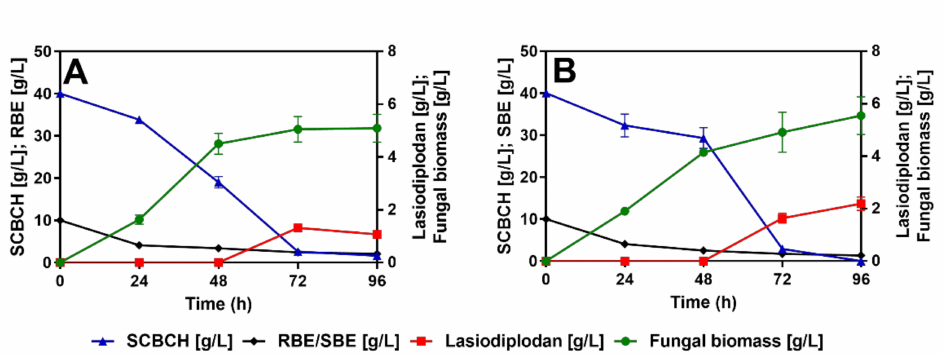
Figure 2. Impact of the lignocellulosic carbon source on the bioproduction of lasiodiplodan and fungal biomass by L. theobromae : ( A ) SCBCH/RBE medium; ( B ) SCBCH/SBE